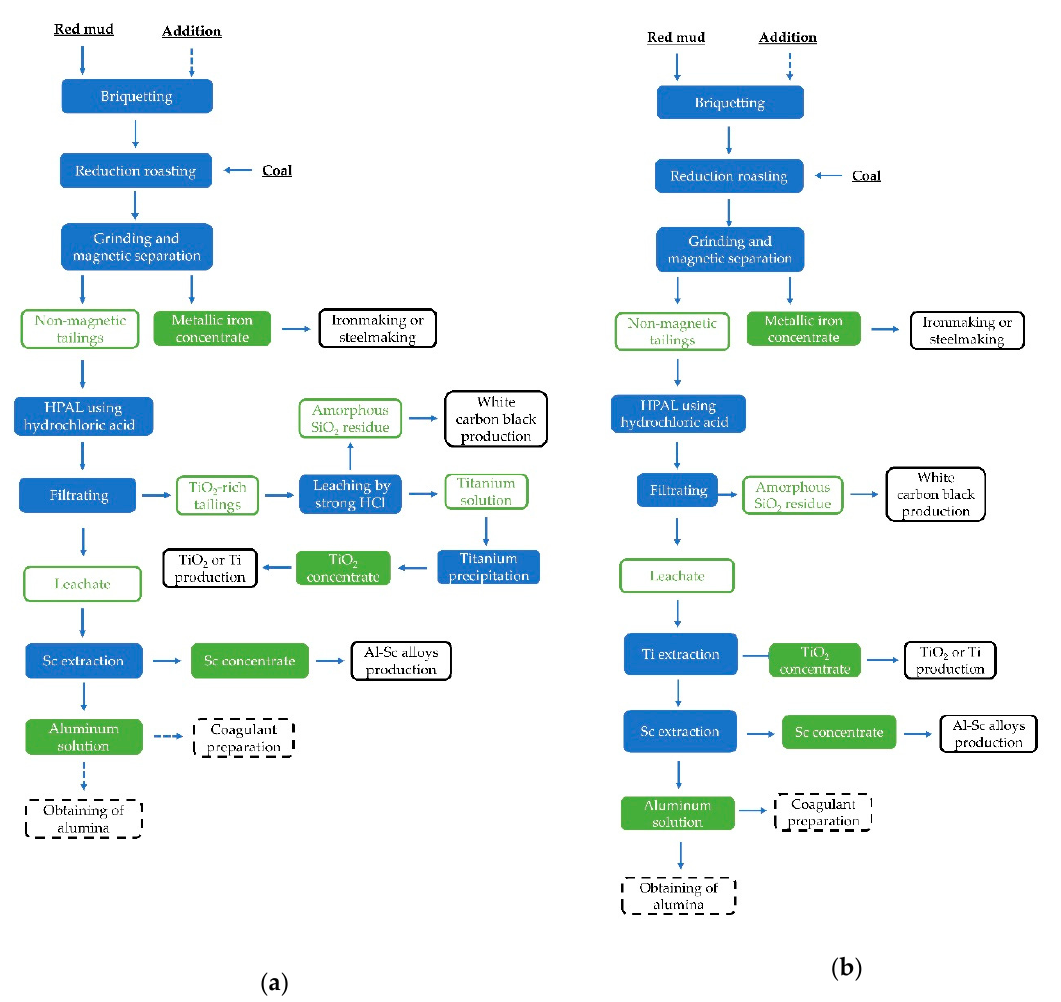
Figure 14. The flowsheets of red mud processing using two ( a ) and one ( b ) leaching stages.